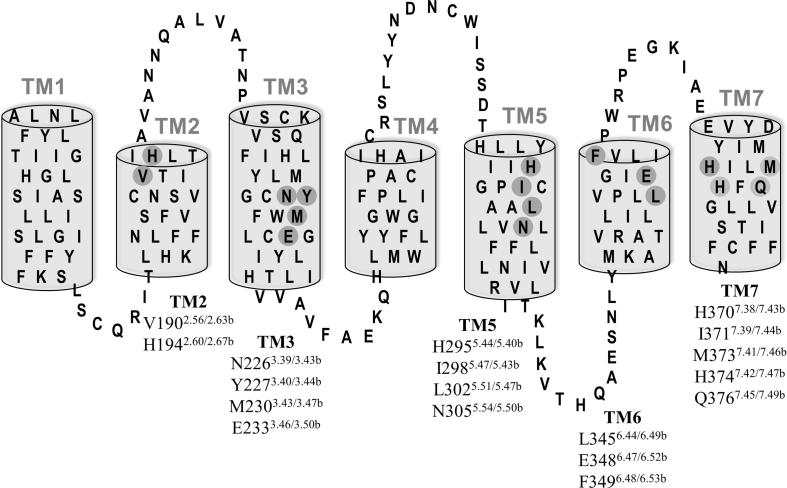
Snake plot of TM residues of CLR; residues selected for alanine substitution are shaded in grey. These residues are numbered according to their primary sequence, followed by the class A/class B numbering in superscript (e.g. V1902.56/2.63b).